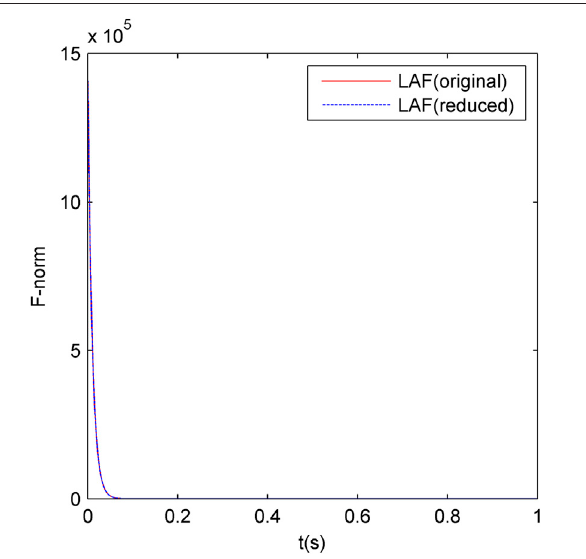
FIGURE 7 | Comparison of the convergence between the original-order and the reduced-order ZNN models under Example